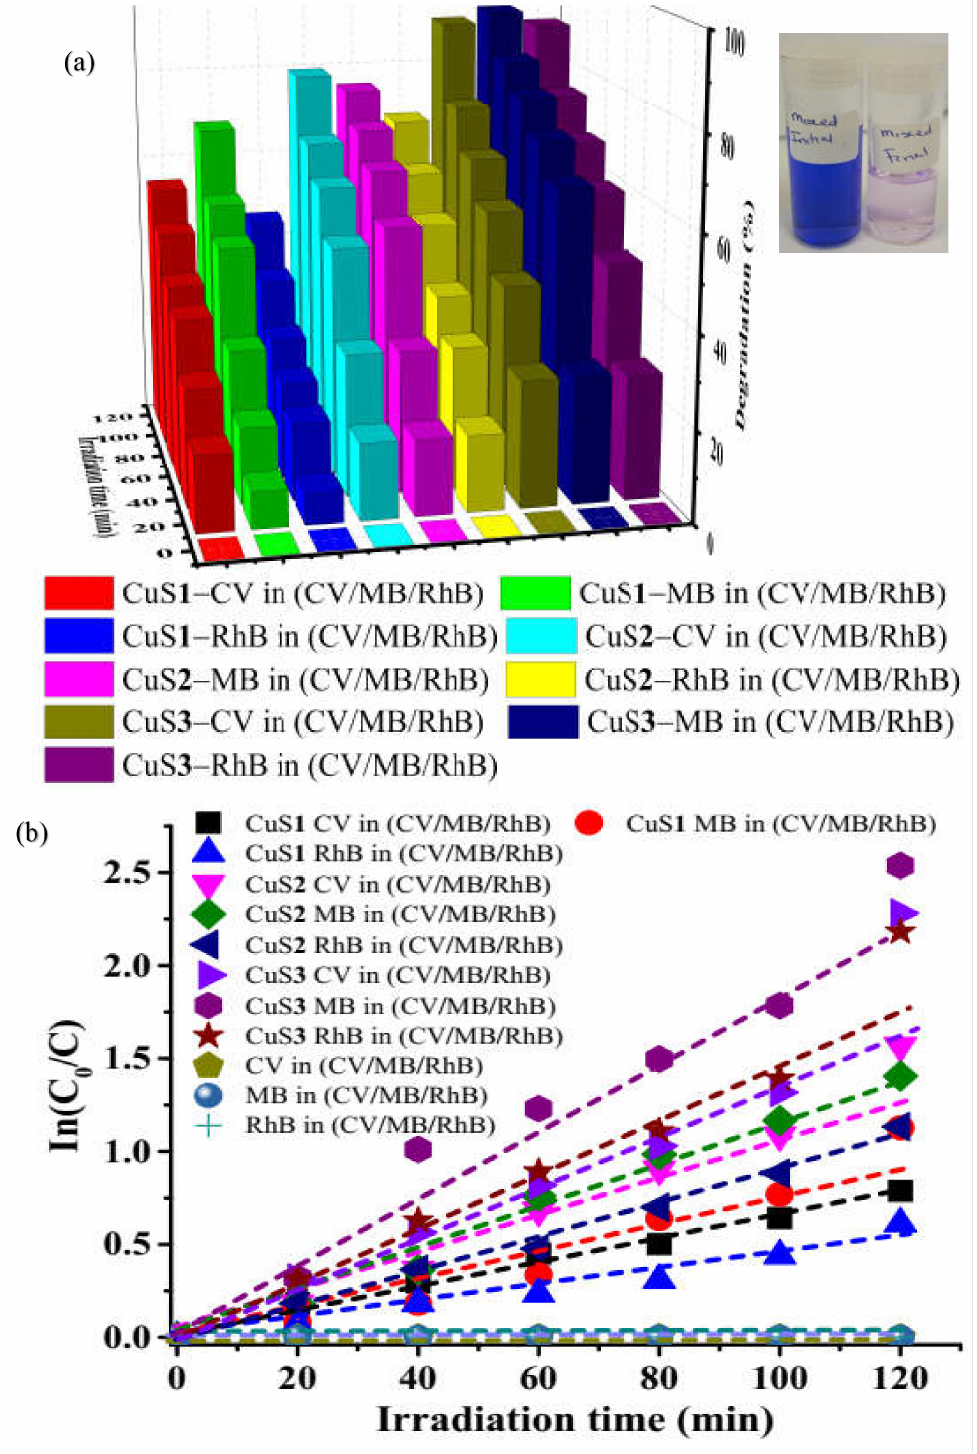
Figure 7. Degradation efficiency bar chart of ternary dyes (mixture of crystal violet, methylene blue, and rhodamine B) ( a ) and kinetics plot ( b ) using CuS